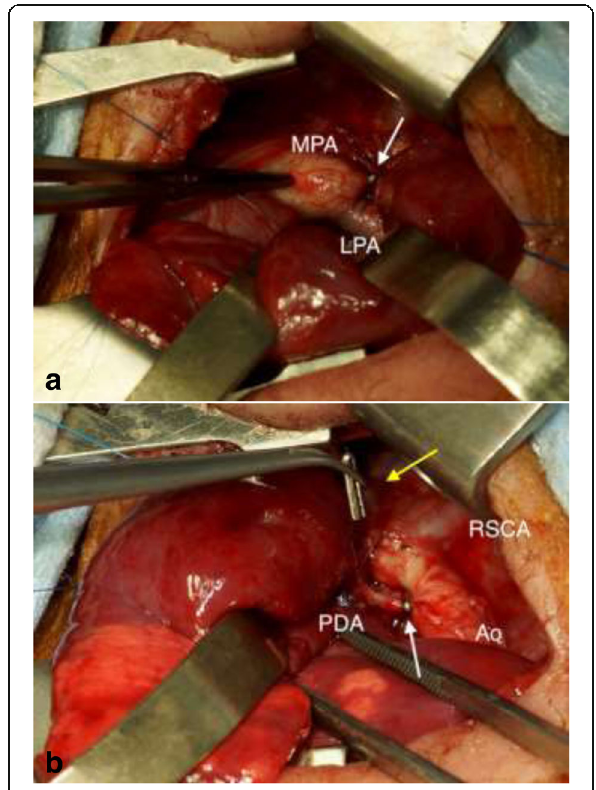
Fig. 3 Surgical procedure. a PDA was clipped at the proximal end through a pericardiotomy (white arrow). b Another new clip was applied on the aortic end (white arrow), and the previous two clips were safely removed (yellow arrow) (Ao = aorta; LPA = left pulmonary artery; MPA = main pulmonary artery; PDA = patent ductus arteriosus; RSCA = right subclavian